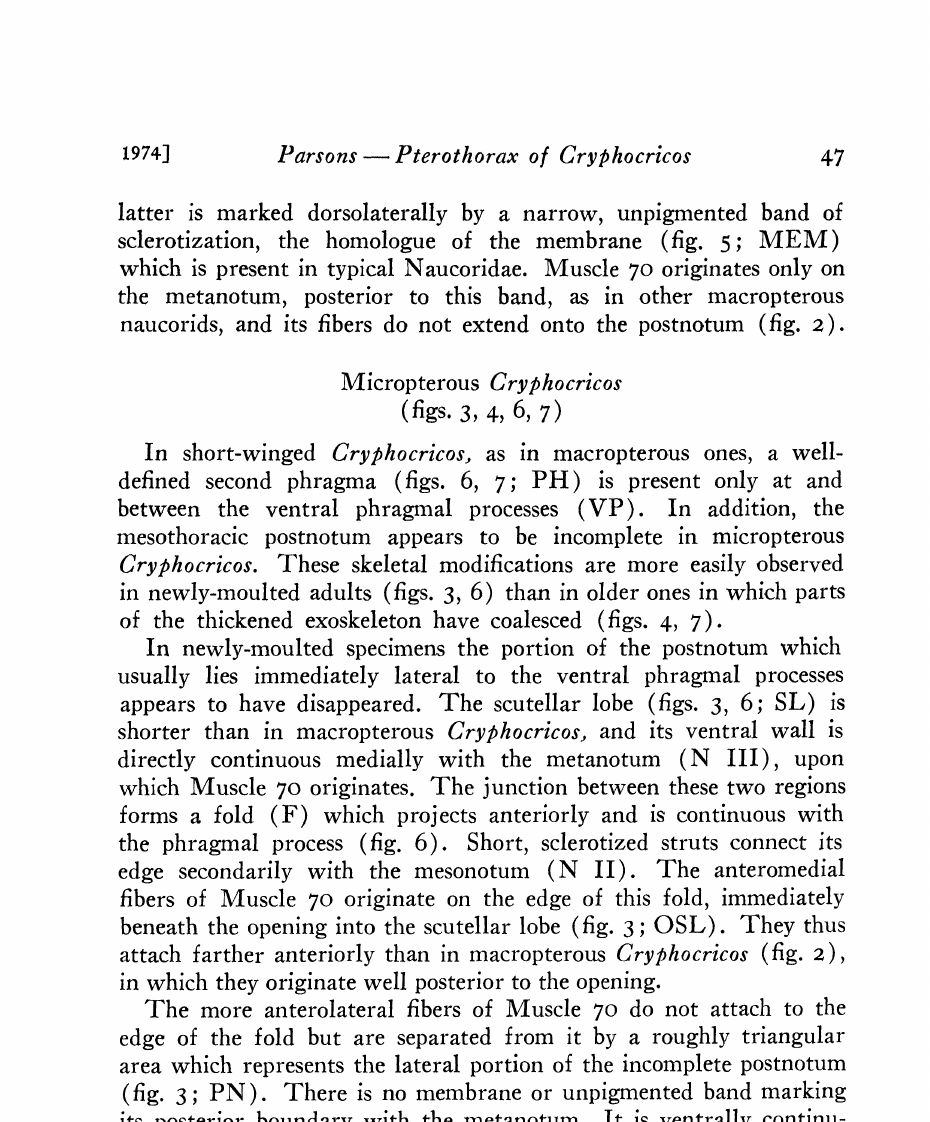
parasagittally, medial to wingbases, and removed from body; only left side, between ventral phragmal process (VP) and cut edge, is shown. Arrow indicates level at which anteriormost fibers of Muscle 7’0 originate. Fig. 5. Pelocoris femoratus (ventral phragmal process cut off at base). Fig. 6. Newly-moulted micropterous Crylhocricos barozzii. Fig. 7. Older micropterous C.